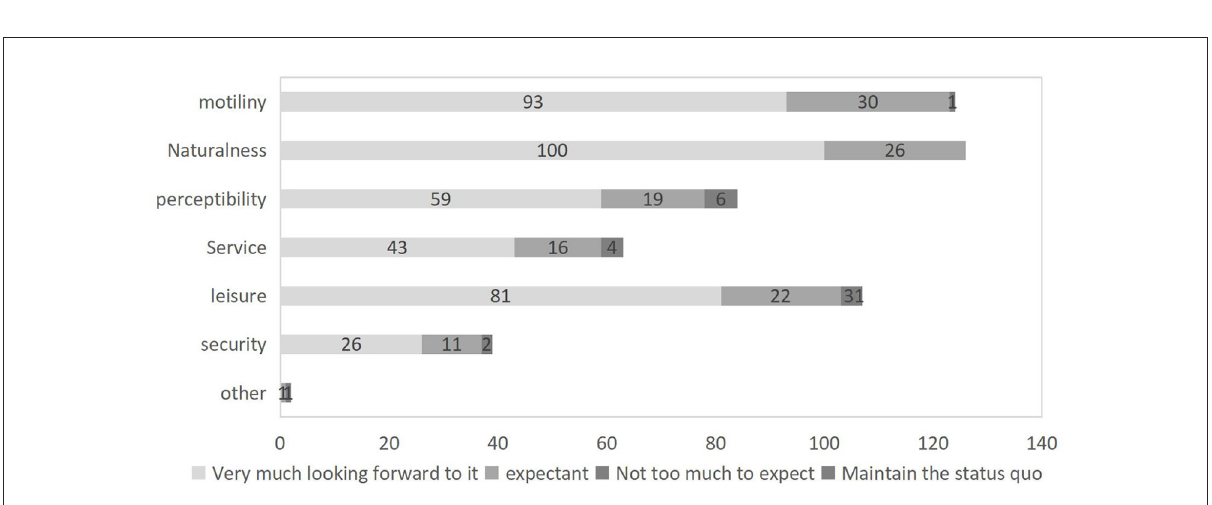
FIGURE3 Survey on the willingness of residents of Dongli community to transform courtyard space.